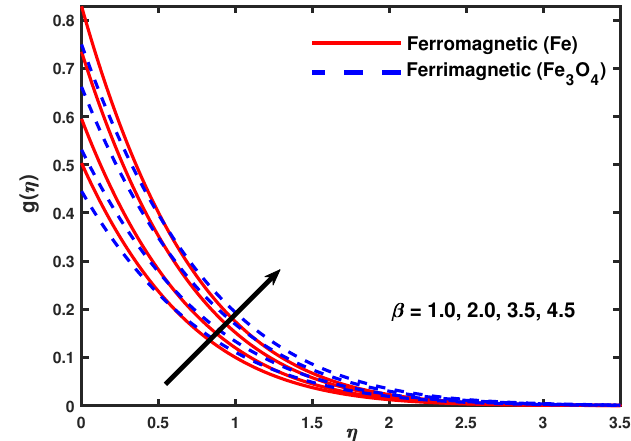
Figure 6. Impact of magnetic nano-particles and ferromagnetic parameter ( β ) on the micro-rotaion velocity g ( η ) .